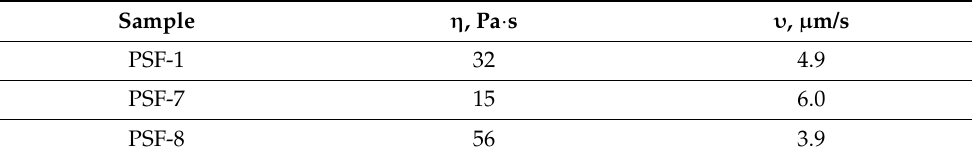
Table 4. The coagulation rate of PSF/NMP/PEG-400 dope solutions (21/49/30 wt.%).